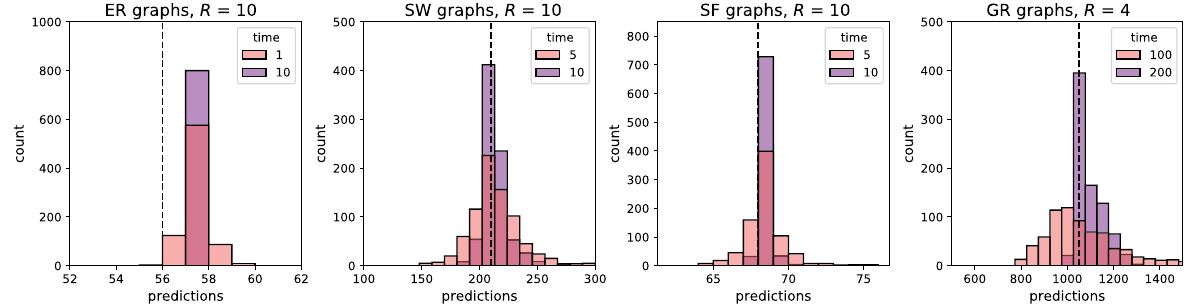
Figure 11. Distributions of expected times to achieve the desired accuracy R , predicted by each node using estimates of average local metrics. The dotted line indicates the actual time the condition was satisfied in 800 and deg 16 . The SW network simulations. The four graphs belong to different families, but all have n avg = = 0.125 , while the SF network has p 0.75 . The graphs include predictions made at two different has a p r c = = time points to show how they become more accurate over